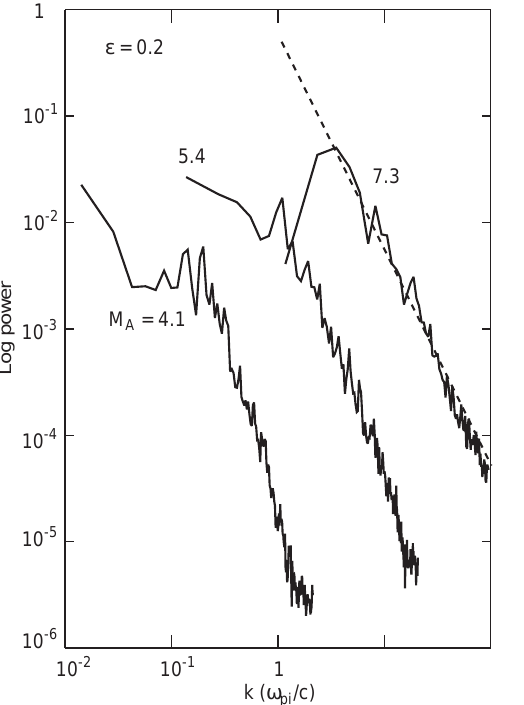
Fig. 7. Power spectra of the magnetic field upstream of a M